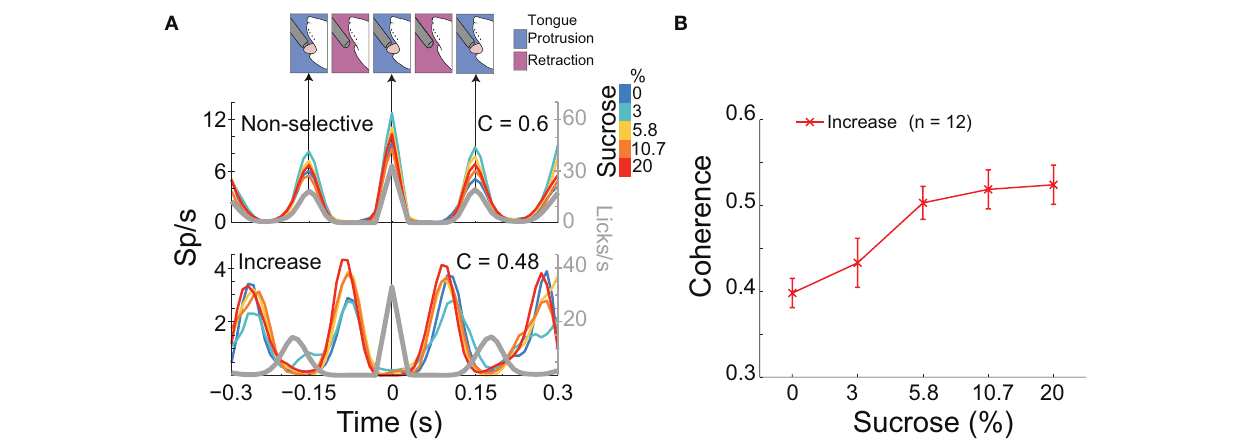
FIGURE 5 | A population of NAcSh neurons can track sucrose concentrations by increasing their coherence with licking. (A) Upper: A schematic of the temporal sequence of a rat licking a sipper (time = 0s) and PSTHs of the activity of two lick-coherent neurons aligned to all licks in the 5s Reward epoch. The upper example is from a neuronal response that was recorded in a Gustatory test whose coherence was similar across Trial Types (see color bar inset; r = 0.03, p > 0.05) and that fired when the animal’s tongue made contact with the sipper. Lower: This response shows a lick-coherent neuronal response (recorded in a Start/Stop task) that increased its coherence in a sucrose-concentration dependent manner ( r = 0.45, p < 0.05) and that was phased locked to tongue retraction. The gray trace indicates the lick rate (and time between arrows indicates a lick cycle that is each time the animal’s tongue make contact with the sipper). (B) The mean ( ± sem) of the coherence of all 12 neurons that significantly increased their synchrony with licking as a function of sucrose